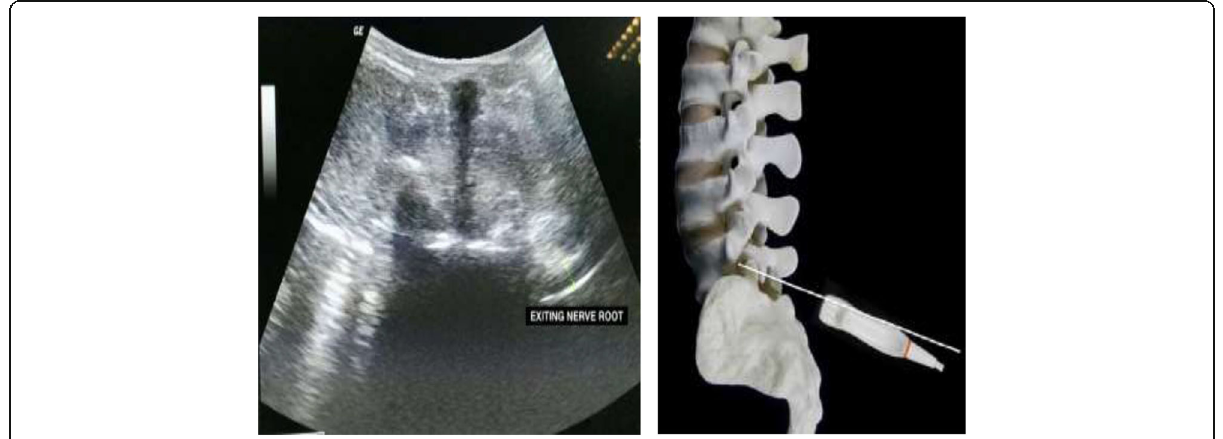
Fig. 2 a Axial sonogram of cadaveric lumbar vertebra shows lower edge of lamina and existing nerve root. b Cadaveric